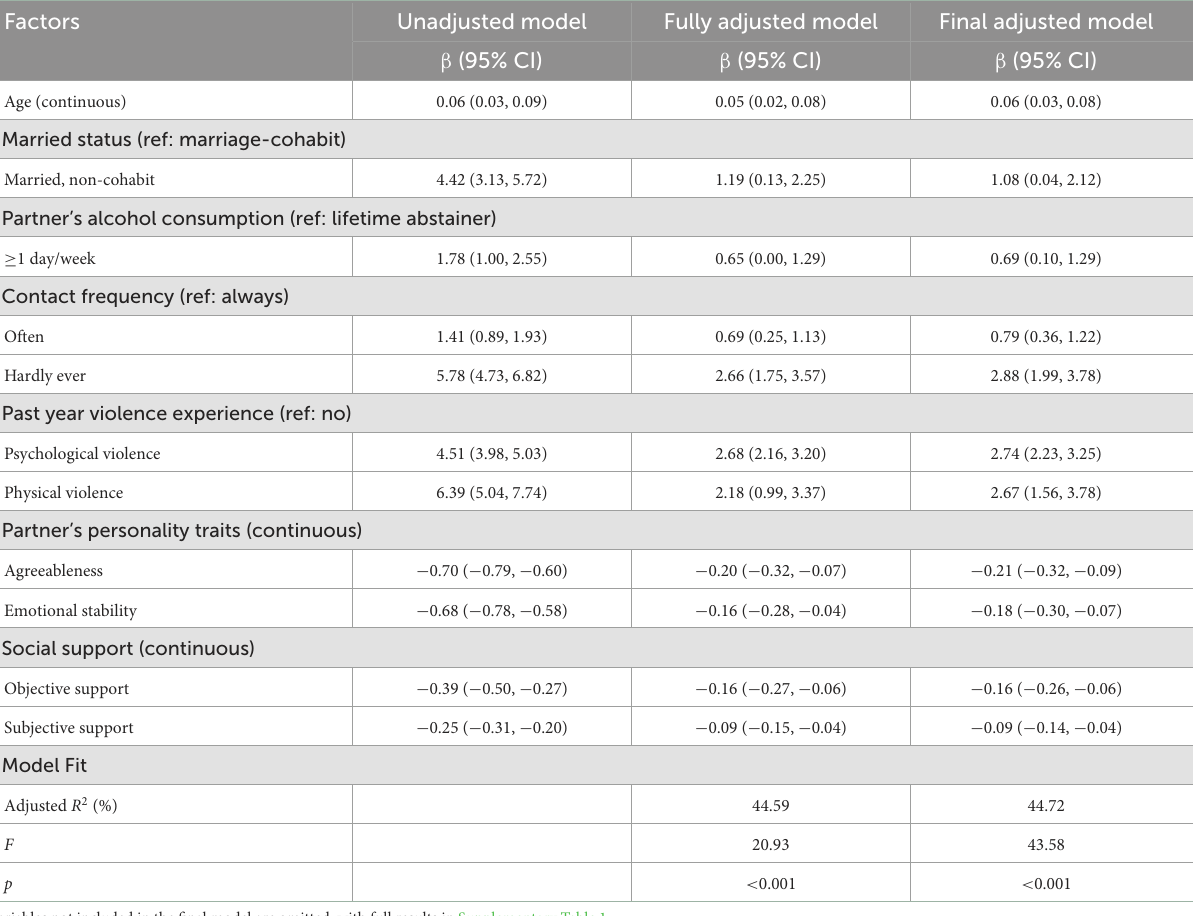
TABLE 3 Linear regression on selected associated factors for psychological violence among Chinese